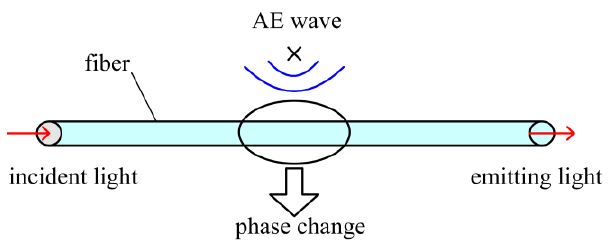
Figure 3. Optical fiber sensing principle.